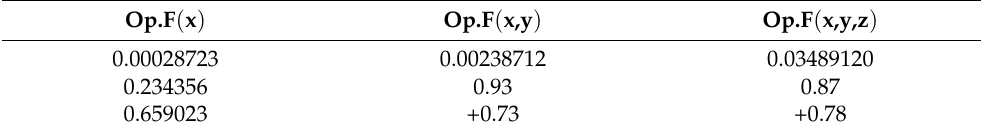
Table 2. Quantified comparison of optimal